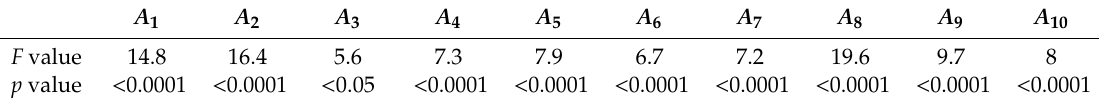
Table 5. Statistical test of the regression formulas.